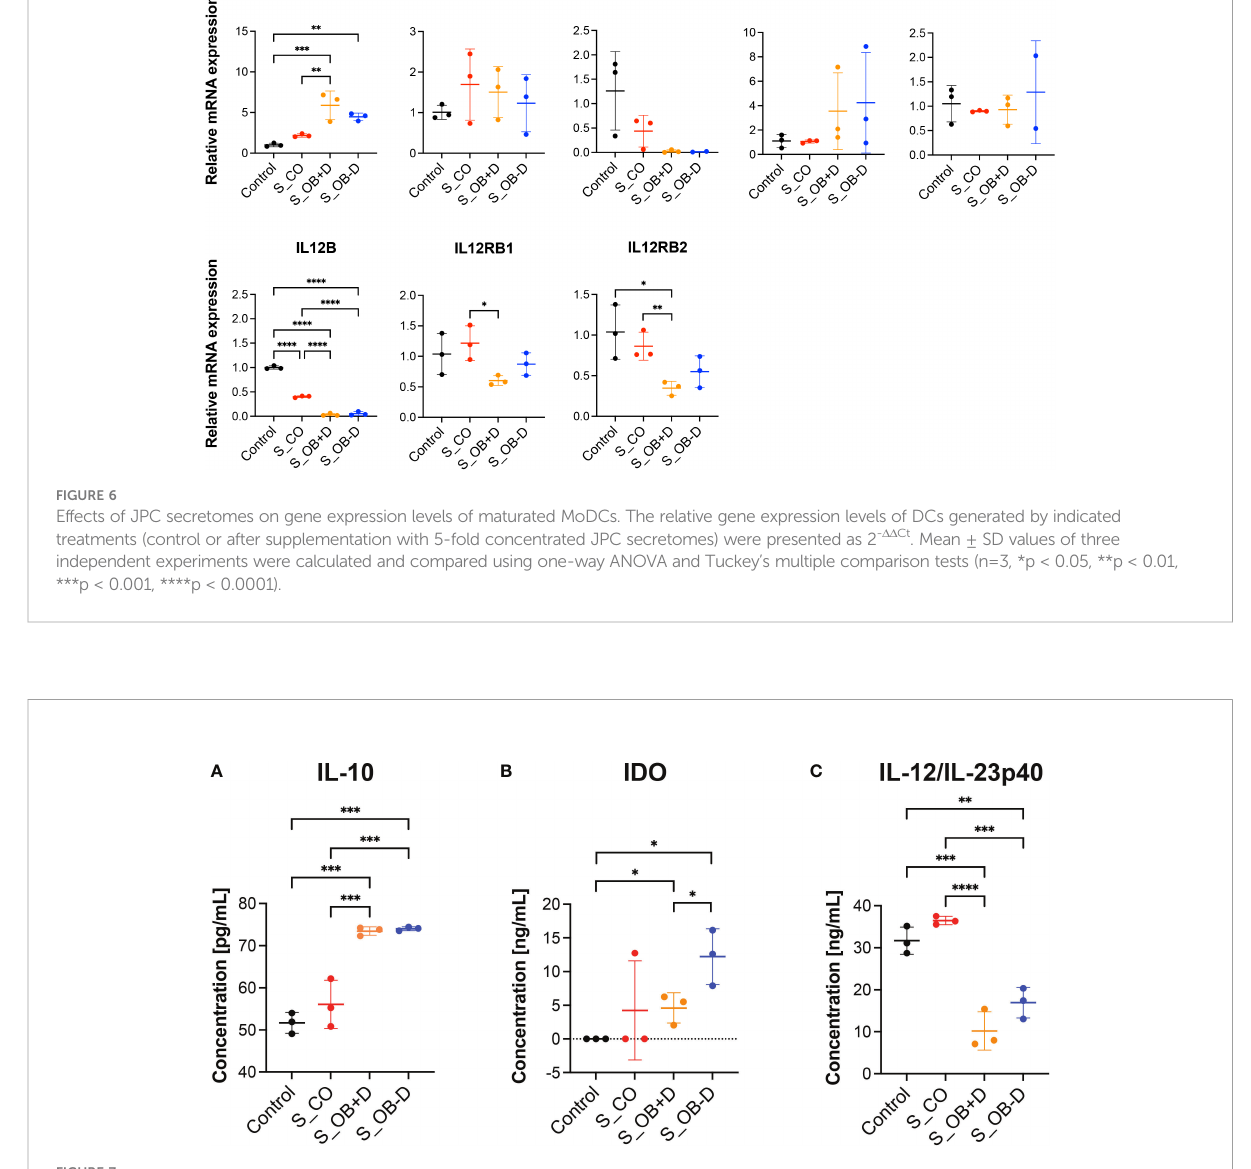
FIGURE 7 Effects of JPC secretomes on protein release by maturated MoDCs. (A – C) IL-10, IDO and IL-12/IL-23p40 levels in supernatants from DCs generated under the indicated treatments (control – without secretome or after the addition of 5-fold concentrated JPC secretomes). Quanti fi cation was performed using speci fi c ELISAs. Mean ± SD values of three independent experiments were calculated and compared using multiple t tests (n= 3, *p < 0.05, **p < 0.01, ***p < 0.001, ****p <